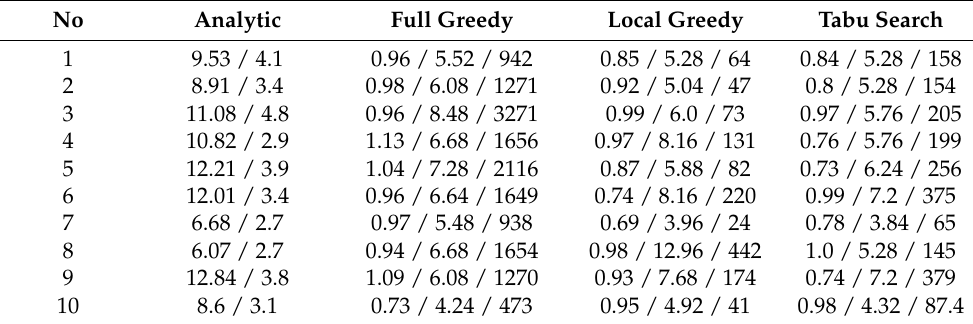
Table 4. Results of the